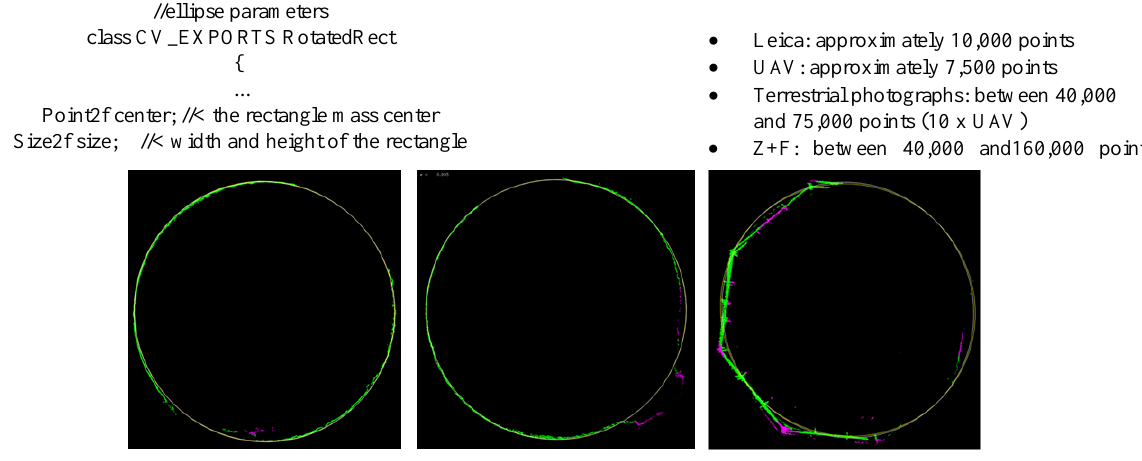
Figure 6: Analysis of the distance between an ellipse and points in sections (gross errors are marked as violet, while correct points are marked as